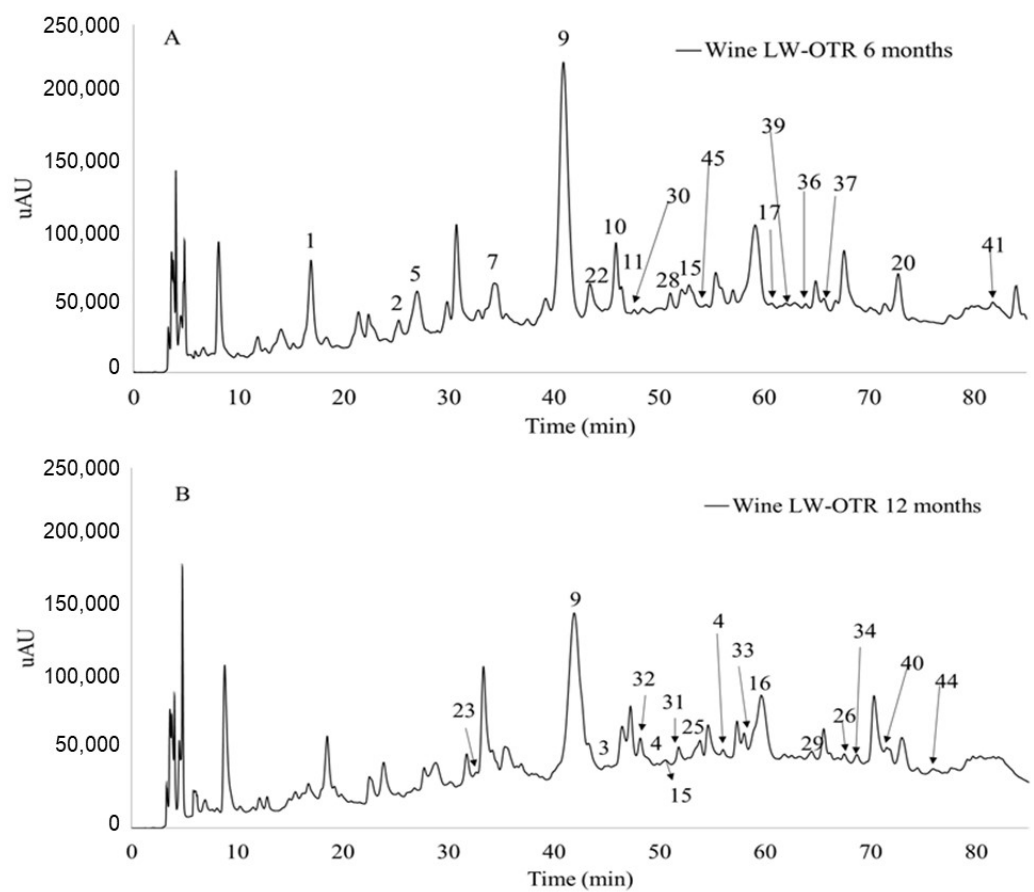
Figure 1. Chromatogram recorded at 520 nm of wine aged in LW-OTR barrels ( A ) aged 6 months ( B ) aged 12 months. The peaks numbers correspond to the compounds identified in Table 3.